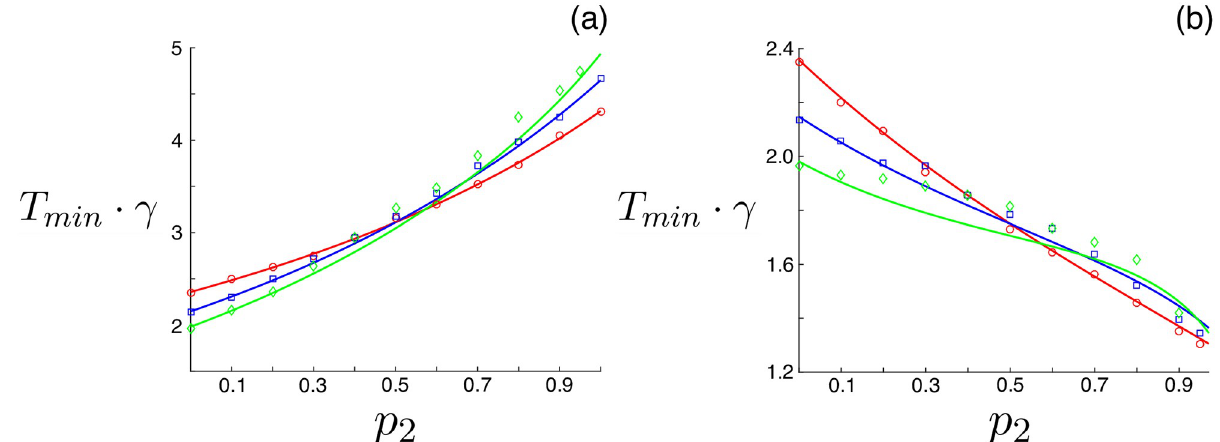
Fig 4. Optimal closure period for a heterogeneous SEIR model with symptomatic and asymptomatic infection as a function of the fraction of asymptomatics. (a) Increased infectivity for asymptomatics, β 1 = 2.1 � γ 1 and β 2 = 2.6 � γ 2 . The solid lines are theoretical predictions and the points are simulation-determined minima for initial fractions of non-susceptibles 10 − 5 . Each series has different recovery times: red ( g (cid:0) 1 g (cid:0)